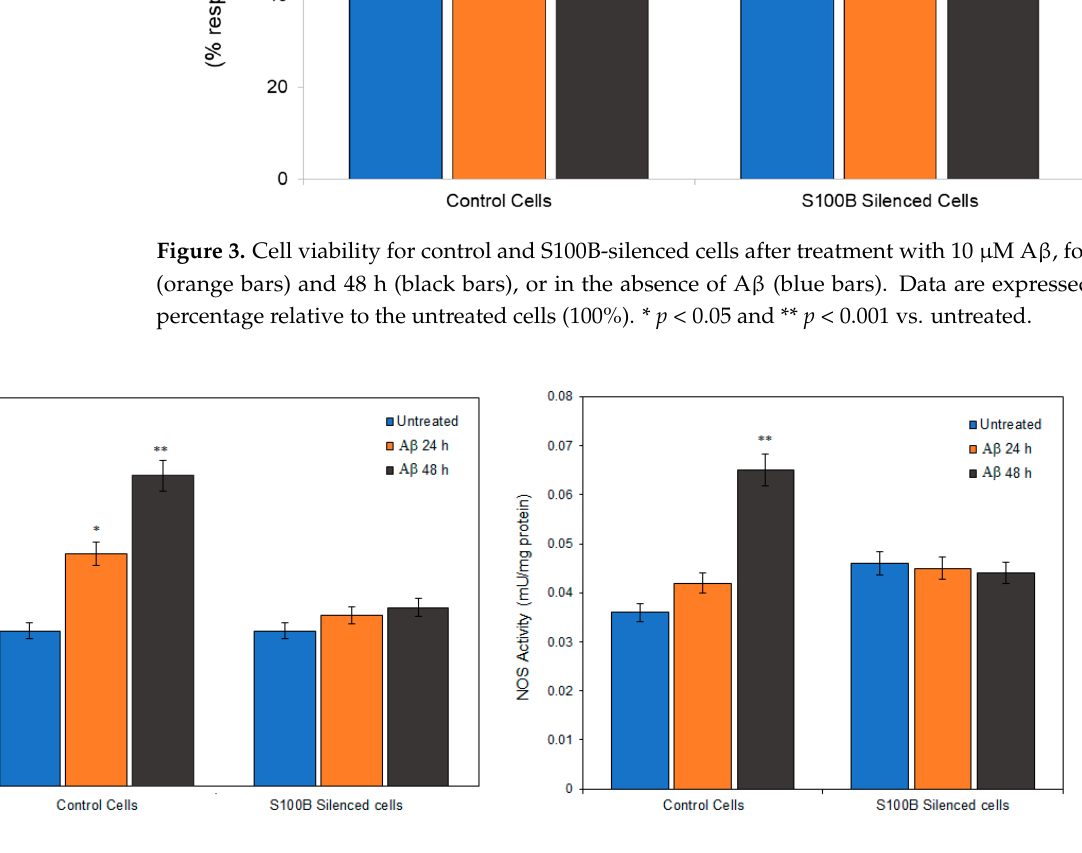
Figure 3. Cell viability for control and S100B-silenced cells after treatment with 10 μ M A β , for 24 h (orange bars) and 48 h (black bars), or in the absence of A β (blue bars). Data are expressed as a percentage relative to the untreated cells (100%). * p < 0.05 and ** p < 0.001 vs. untreated.